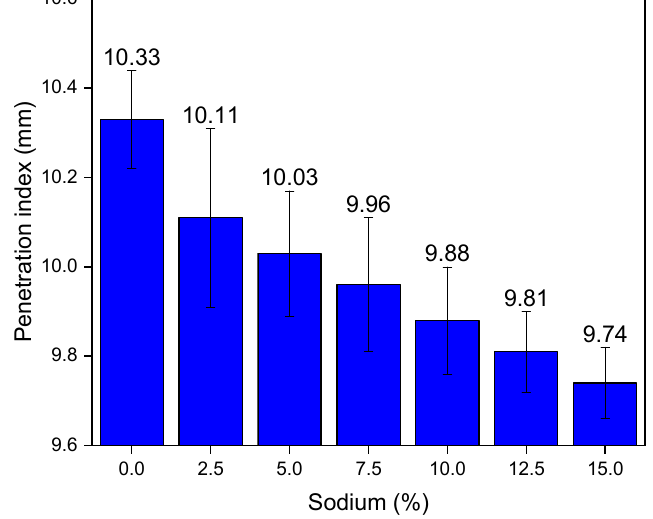
Figure 4. Dropping ball results.